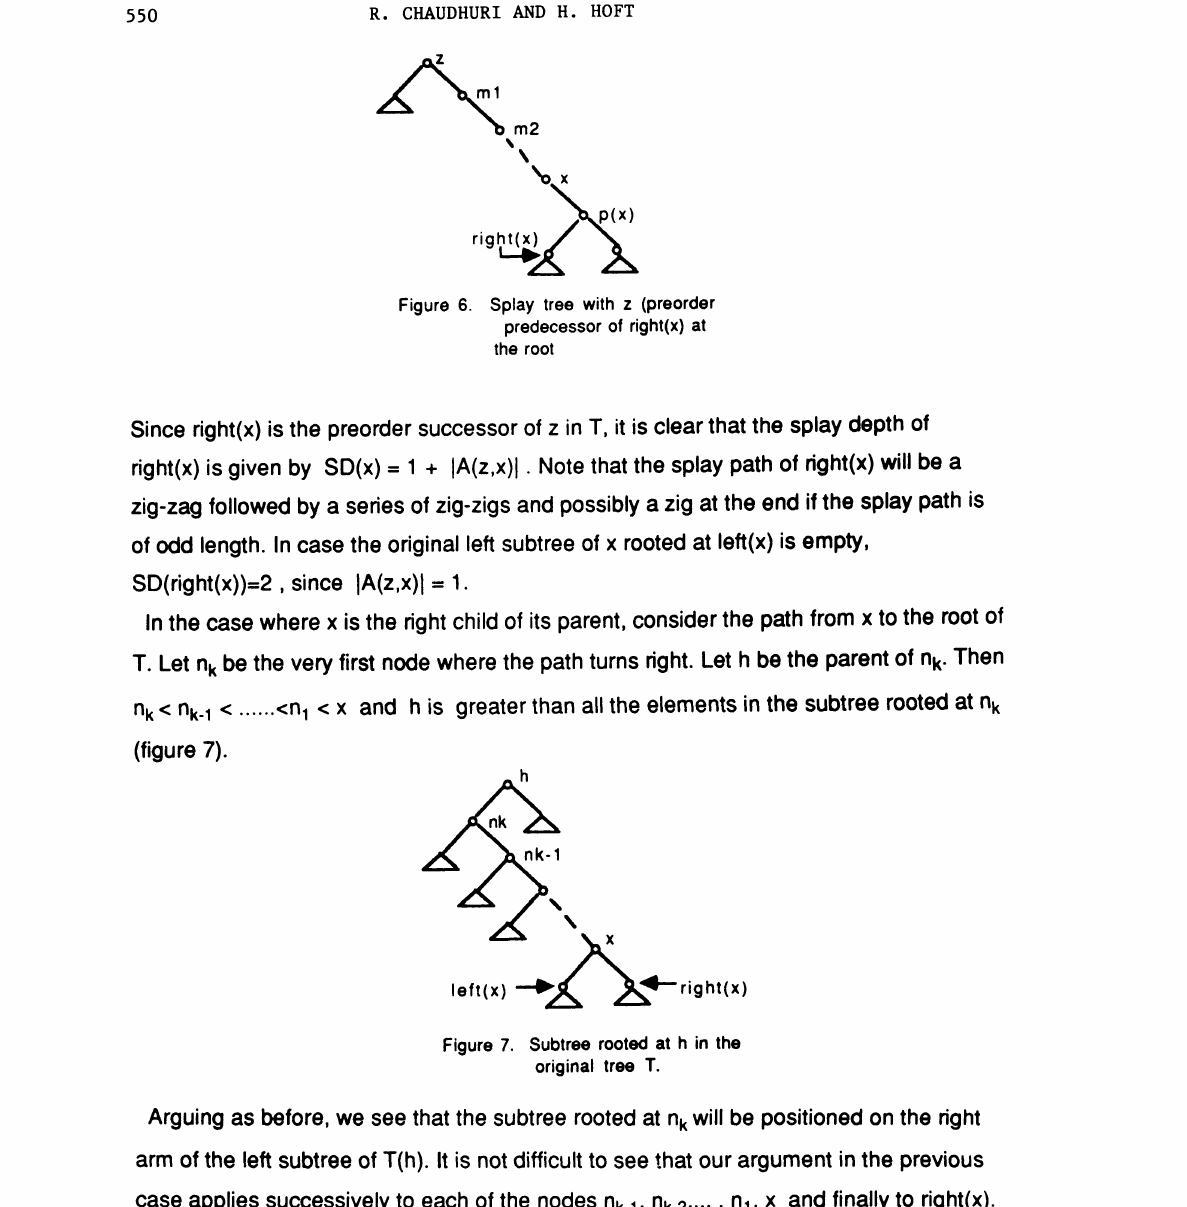
Figure 7. Subtree rooted at h in the original tree T.